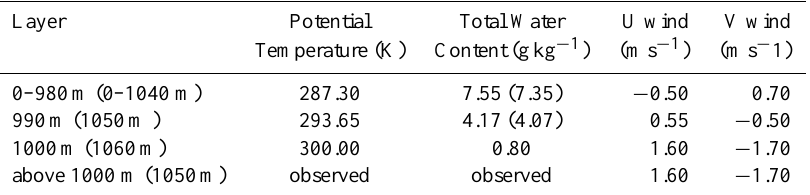
Table 3. Thermodynamic profile (sounding) used to initialize model. Where applicable, original values from observations (before modifi- cation for use in this study) are shown in parentheses. The surface pressure was initialized at 1018.0mb. Temperature and moisture values above the inversion were those observed immediately before the flight